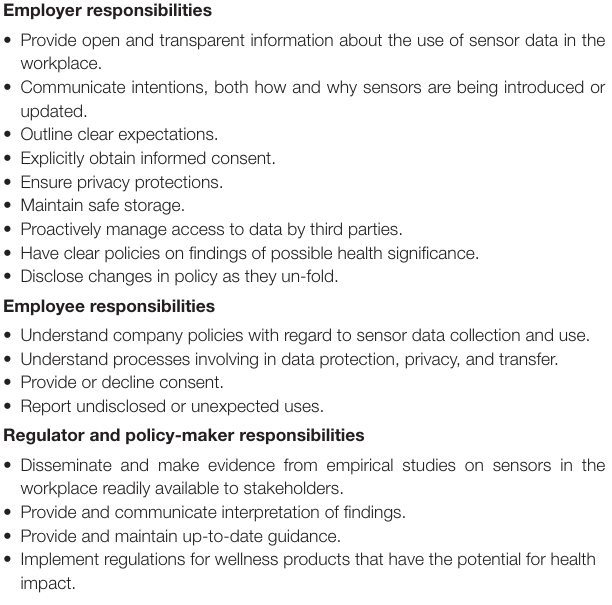
TABLE 2 | Recommendations for the responsibilities of employers, employees, and